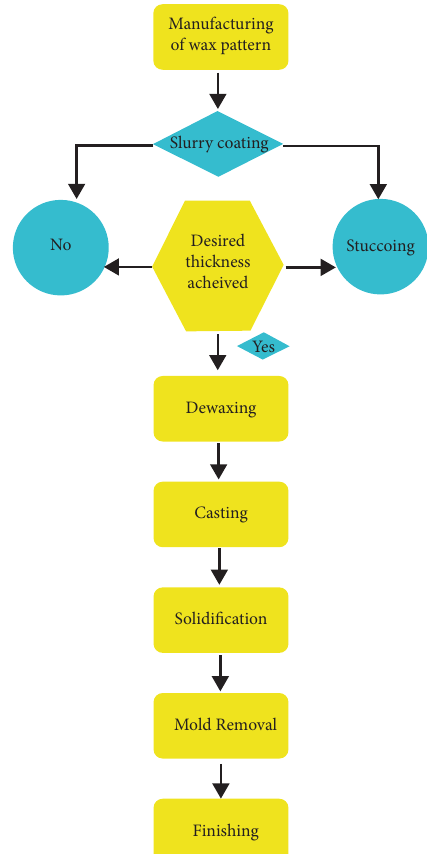
Figure 3: Process of investment